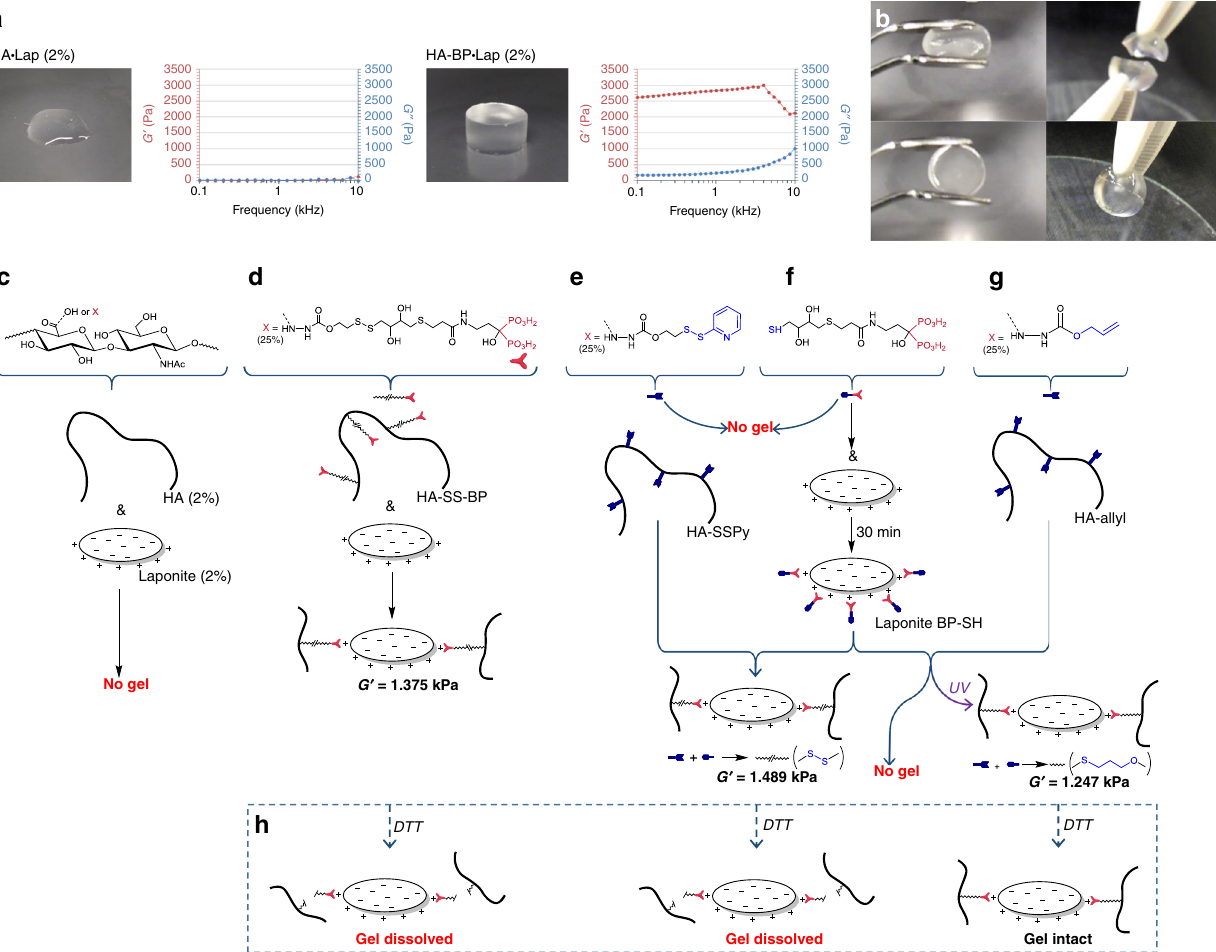
Fig. 1 Laponite bisphosphonate interactions allow physical cross-linking of hydrogels. Laponite addition (2% wt. vol.) to a bisphosphonate